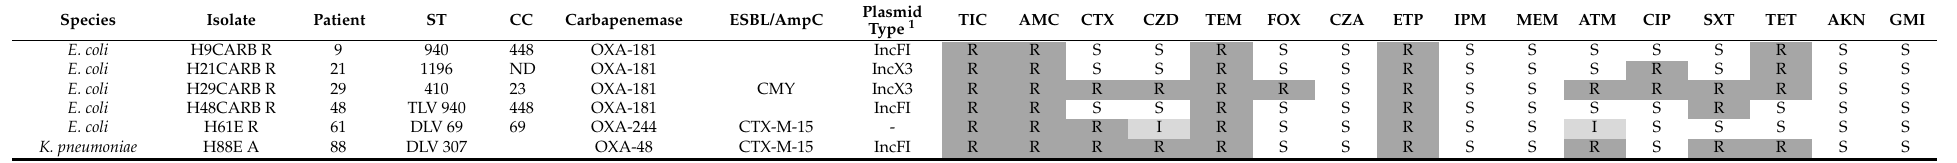
Table 4. Characteristics of the 6 carbapenemase-producing